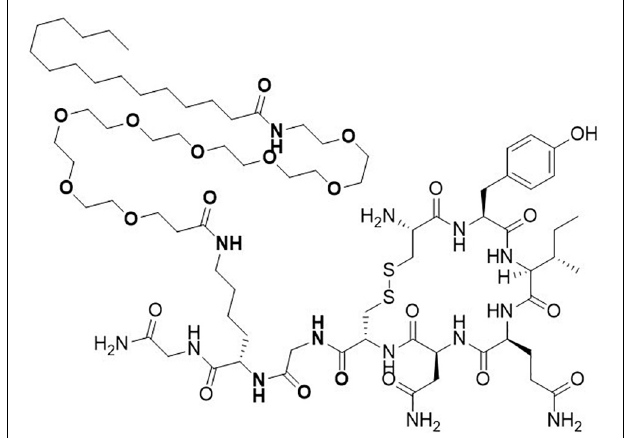
FIGURE 1 | Structure of novel long-acting oxytocin analog ASK1476. The native oxytocin peptide was modified with a substitution of the Leu8 to a Lys appended with a polyethylene glycol space and a palmitoyl group and with a substitution of Gly for the Pro7 to enhance selectivity for the OXT receptor.